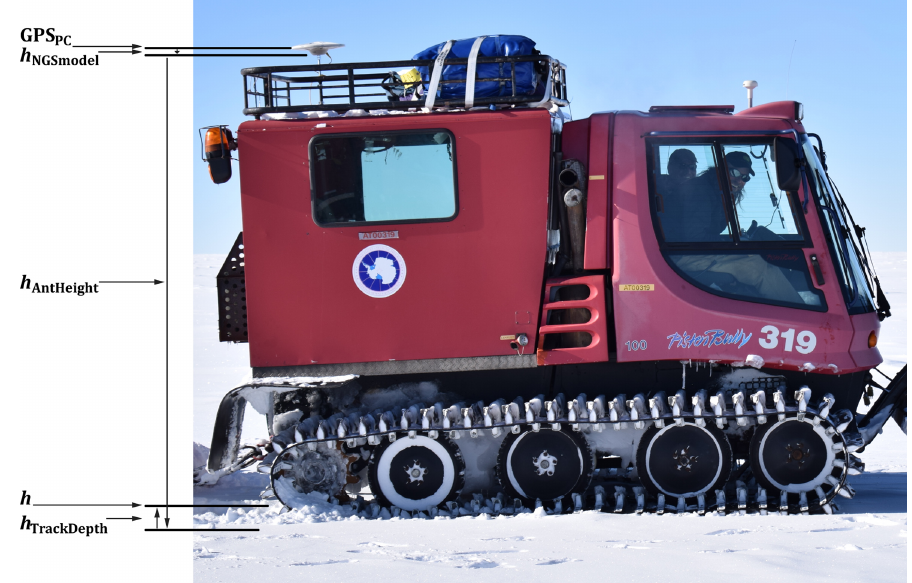
Figure 2. The GPS antenna configuration on a PistenBully. GPS PC is the surveyed position solution to the phase center of the antenna, h NGSmodel is the NGS model distance between the antenna phase center and the antenna base plane, h AntHeight is the distance between the antenna base plane and the indentation of the tracks in the snow, h TrackDepth is the depth of the sled runners in the snow surface, and h is the snow surface (Eq.